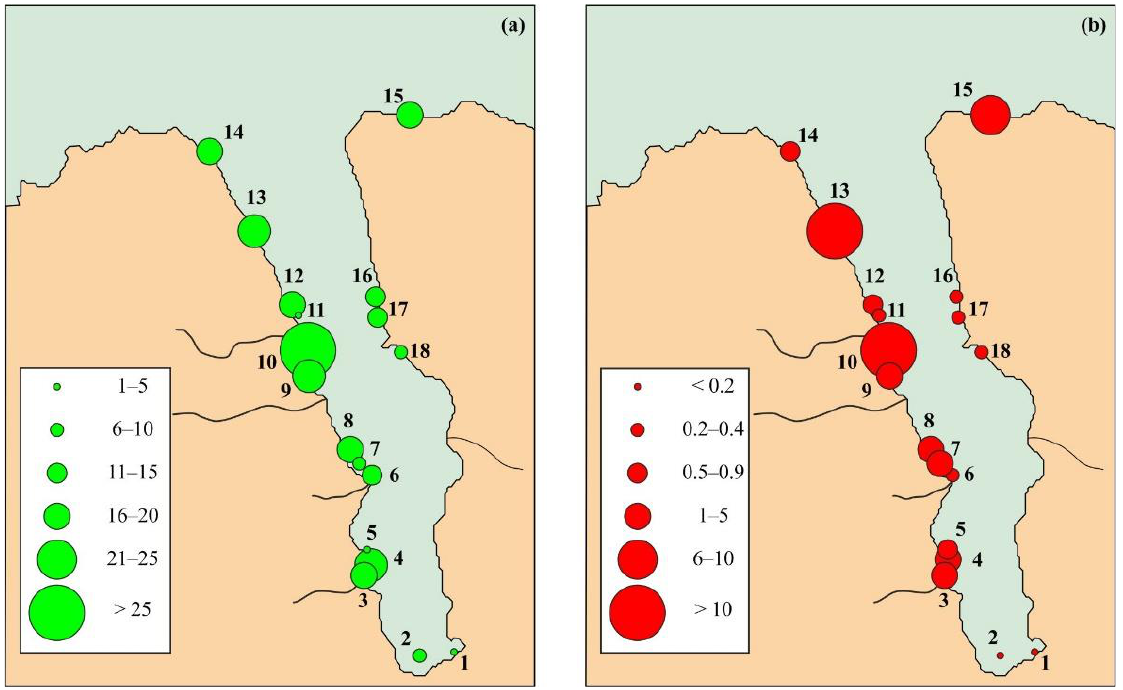
Figure 4. Variations in bryozoan species richness ( a ) and biomass ( b ), g m − 2 , in Grønfjorden. The highest values of H (cid:48) (3.36) and J (cid:48) (0.822) were found at Station 14. Mean values for SR, H (cid:48) , and J (cid:48) were 15.1 ± 2.6, 1.81 ± 0.22, and 0.459 ± 0.053, respectively. The Chao2 index was calculated to be 80, indicating that we sampled 78% of the estimated taxa pool. Bryozoan biomass varied in a wide range throughout the study area (Figure 4b), with minimum values (0.008 and 0.043 g m − 2 ) being registered at the head of the fjord (Sta- tions 1 and 2, respectively), and maximum values occurred at Stations 10 (10.938 g m − 2 ), 13 (10.758 g m − 2 ), and 15 (6.044 g m − 2 ). Overall, 95% of the total biomass was provided by 18 species, among which the highest contributions to the total material were found for Eucratea loricata (27.5%), Tricellaria gracilis (12.5%), Turbicellepora incrassata (9.1%), Tri- cellaria ternata (9.1%), Alcyonidium hirsutum (7.0%), Crisiella producta (5.8%), and Celle- porella hyalina (4.4%). The average bryozoan biomass in Grønfjorden was calculated to be 2.67 ± 0.82 g m − 2 . Cluster analysis of the bryozoan community composition and biomass revealed two groups at a 36% similarity level (Figure 5a), separating Stations 6, 7, 16, 17, and 18 (Cluster 1) from Stations 3, 4, 8, 9, 12, 13, 14, and 15 (Cluster